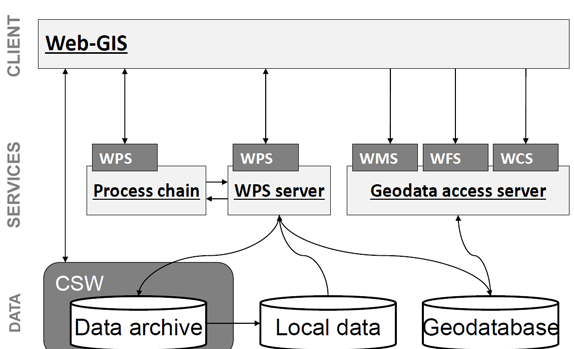
Figure 1. Technical schema of the implemented system